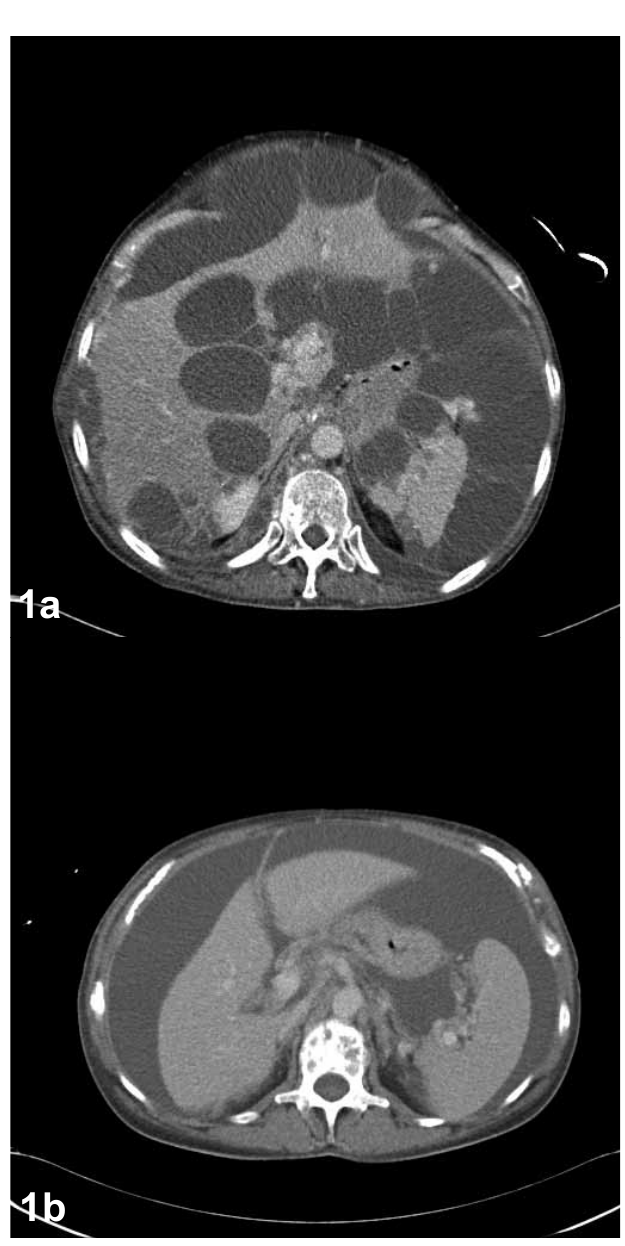
Fig. 1. Multiple complex cystic masses of fat density in the peritoneum (1a), and characteristic scalloping of the liver and spleen margins